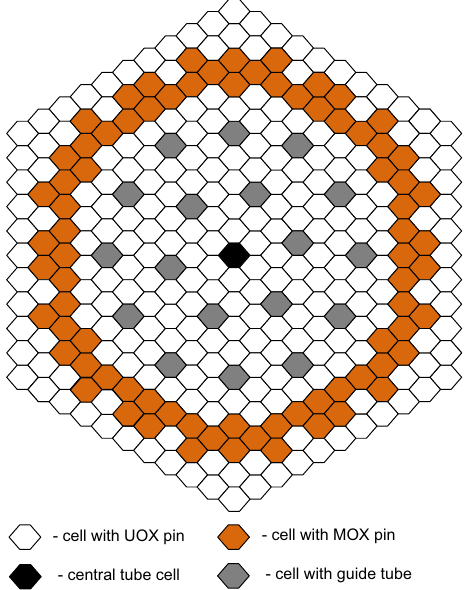
Fig. 3. The REMIX (het) FA con fi guration for heterogeneous fuel pin positioning.